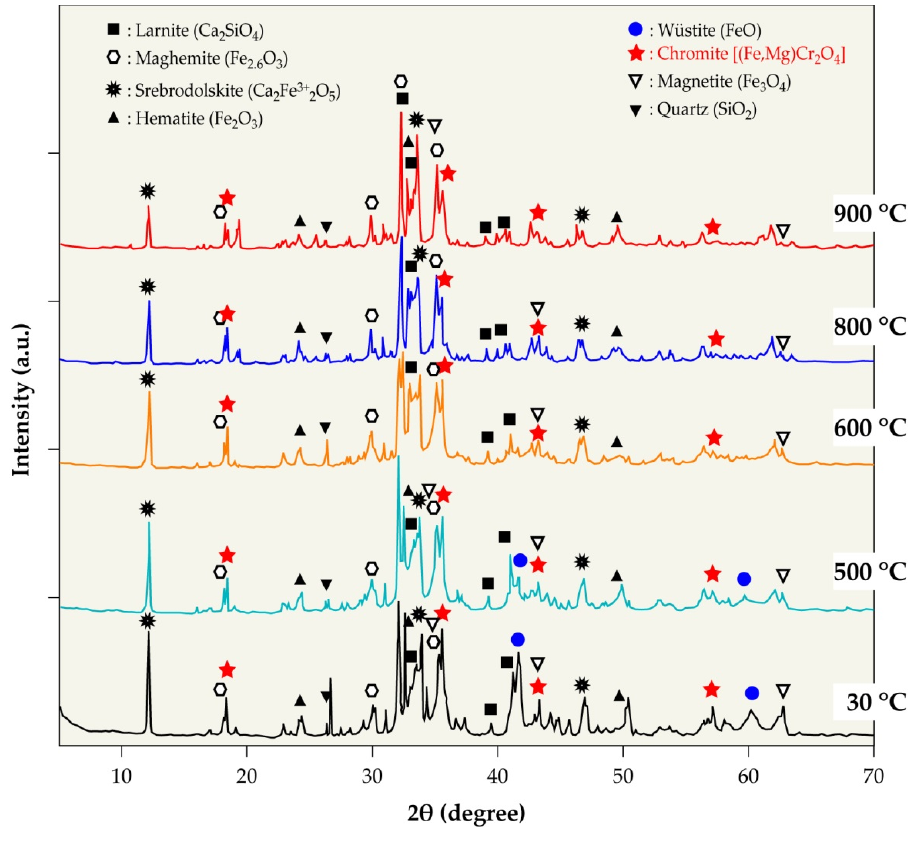
Figure 11. High temperature X ‐ ray diffraction (HT ‐ XRD) patterns of slag heated from 30 to 900 °C in an air atmosphere (1 bar). Table 4. XRD evaluation of EAF slag modifications during treatment in air from 30 to 900 °C.